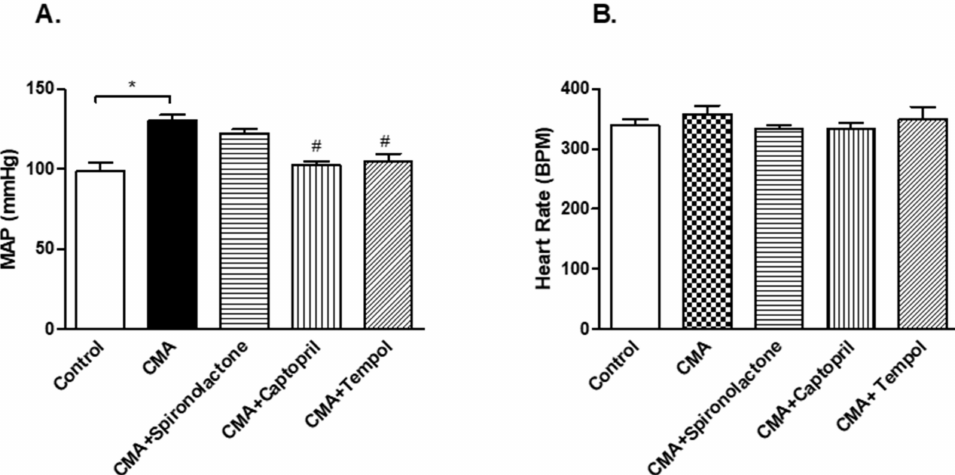
Figure 4. Inline-pressure transducer readings for MAP and heart rate. Each bar represents values expressed as mean ± SEM. ( A ) The change in MAP was considered significant when * p < 0.05 (control vs CMA) groups and # p < 0.05 (CMA vs. CMA + captopril or CMA + tempol) groups. ( B ) No significant changes in heart rates among the groups. The data were analyzed using one-way ANOVA followed by Tukey’s multiple comparison test among all five groups. t -test was performed to compare two individual